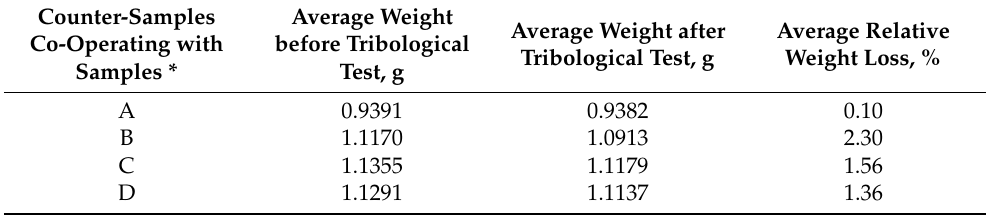
Table 4. A weight loss of counter-samples co-operating with samples of type A, B, C, and